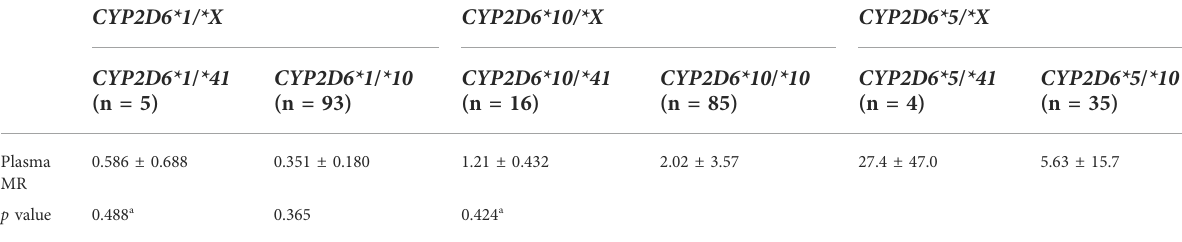
TABLE 3 The plasma MR comparisons between CYP2D6*1/*41 vs. *1/*10, *10/*41 vs. *10/*10, and *5/*41 vs. *5/*10 .